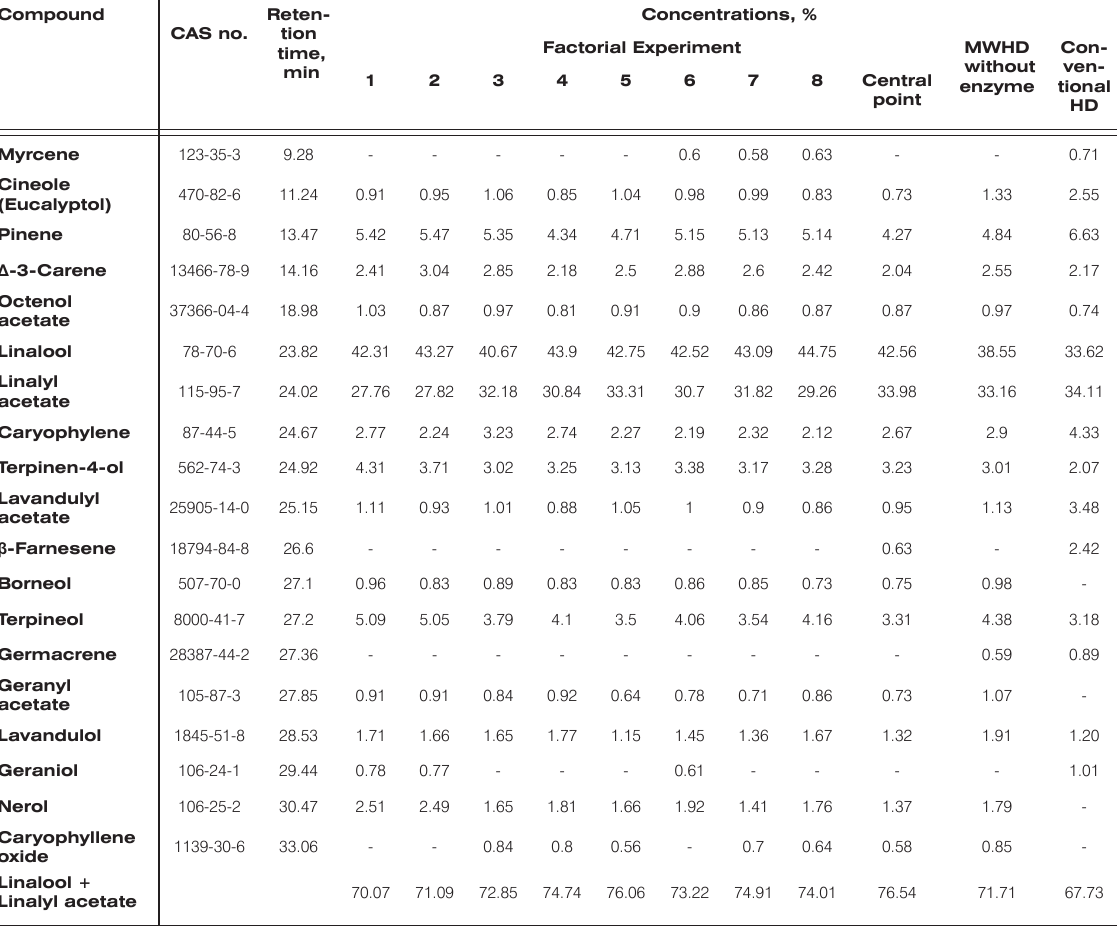
Table 7. Chemical composition of lavender oils obtained by MWHD. Compound